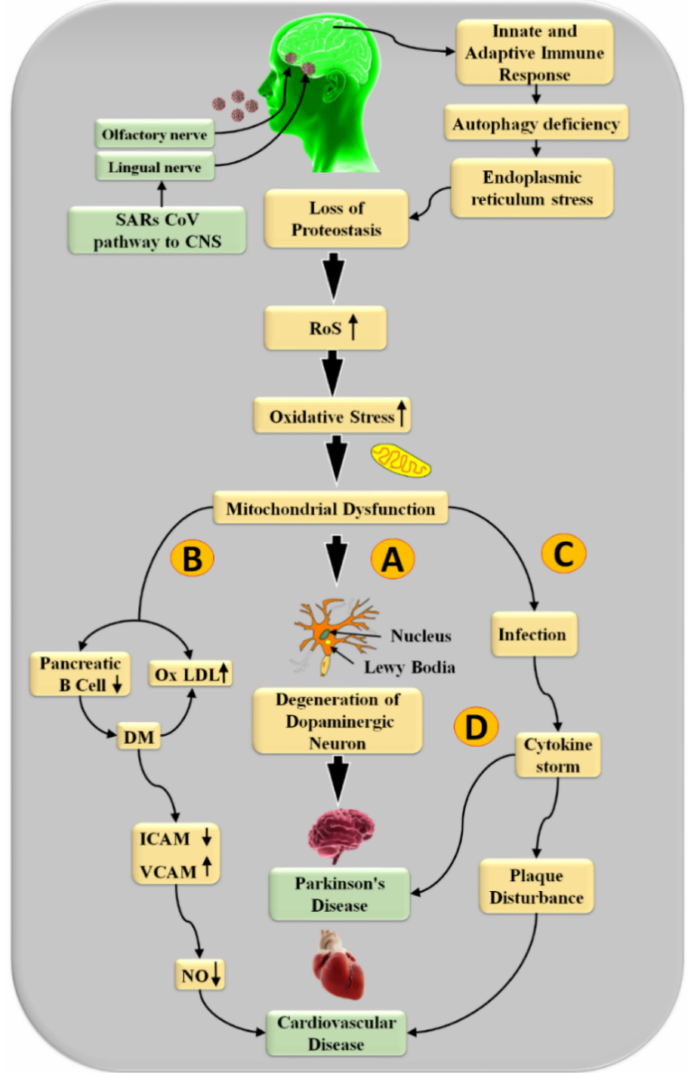
Figure 11. COVID-19 virus pathways leading to stroke and CVD in PD patients (Courtesy of AtheroPoint, Roseville, CA,